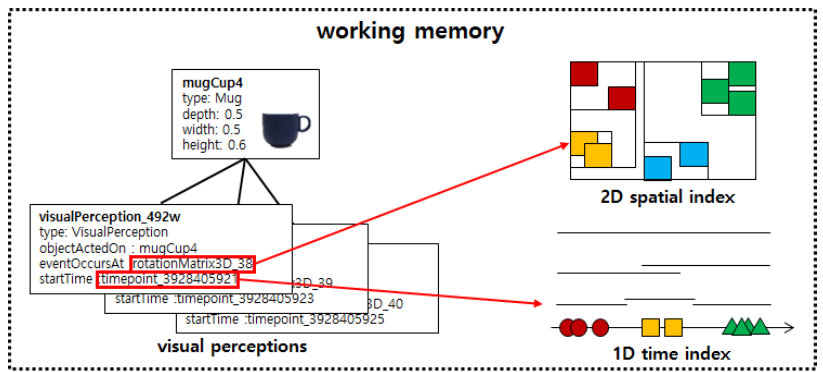
Figure 12. Building of spatio-temporal index for visual perception instances.